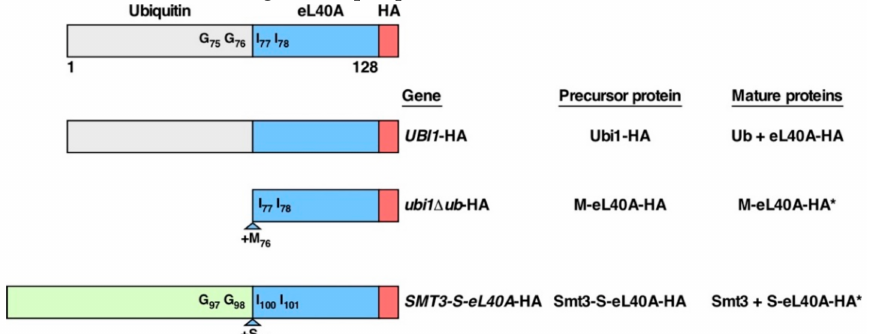
Figure 1. Schematic representation of the genomic constructs used in this study. Ubi1 consists of an N-terminal ubiquitin moiety fused to the r-protein eL40A. A peptide bond between the C-terminal glycine of ubiquitin (G76) and the N-terminal isoleucine of eL40A (I77) connects the two proteins. Relevant residues and ubi1 mutant variants thereof used in this study are also indicated. The relevant constructs are schematically depicted, and the respective allele, precursor protein, and mature protein names are indicated. The asterisk denotes that the exact nature of the mature proteins derived from these precursor proteins has not been experimentally determined; thus, the indicated mature proteins correspond to the most likely in vivo cleavage products. A single C-terminal HA tag was added for western detection of the Ubi1 and / or eL40A protein